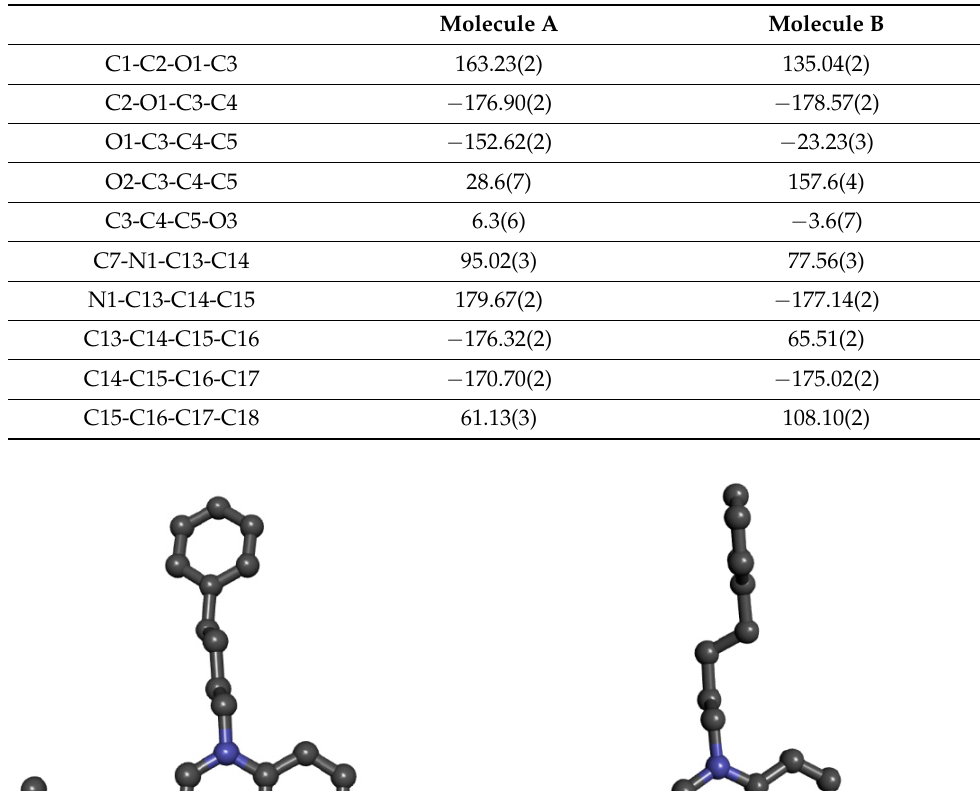
Table 6. Selected torsion angles in 4d .